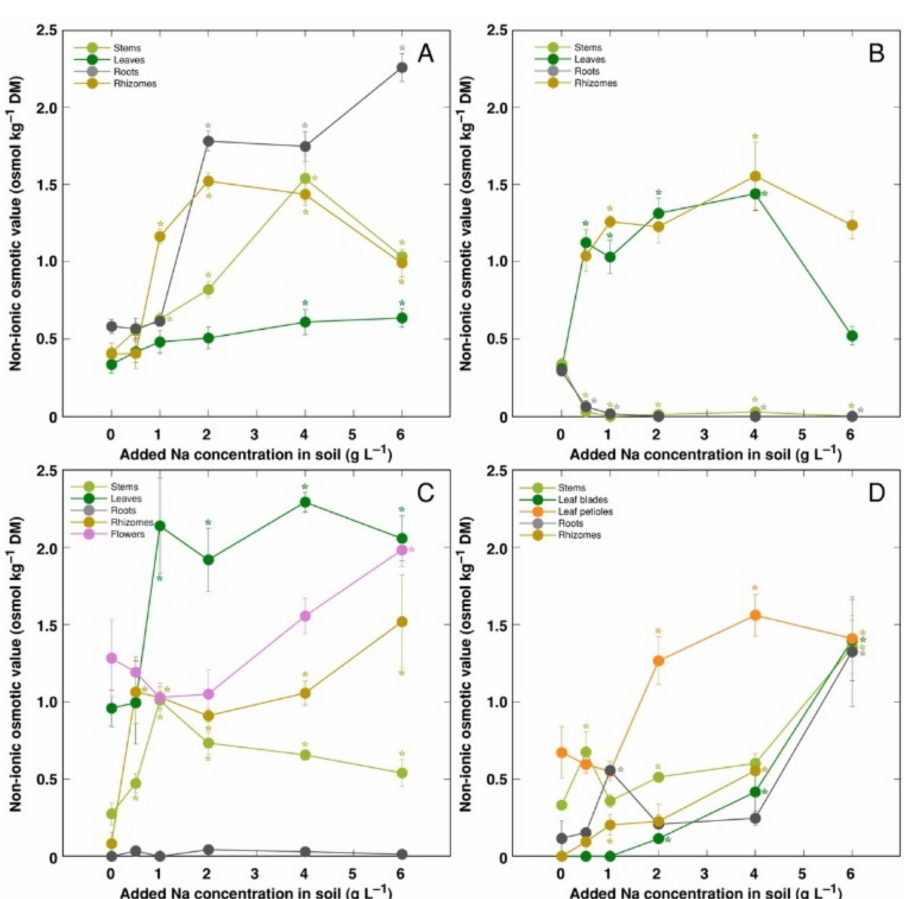
Figure 10. Changes in non-ionic osmotic value under the effect of increasing soil salinity in different parts of Calystegia sepium accessions CSe1 ( A ), CSe2 ( B ), CSe3 ( C ) and Calystegia soldanella ( D ). Na + was added in a form of NaCl. Data are means from three replicates for each concentration ± SE. Asterisks of the respective color indicate statistically significant differences ( p < 0.05) from control.